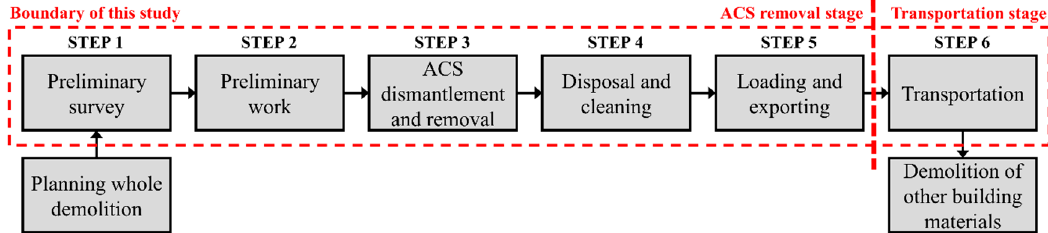
Figure 2. Demolition process of building and boundary of this study: ( 1 ) preliminary survey;